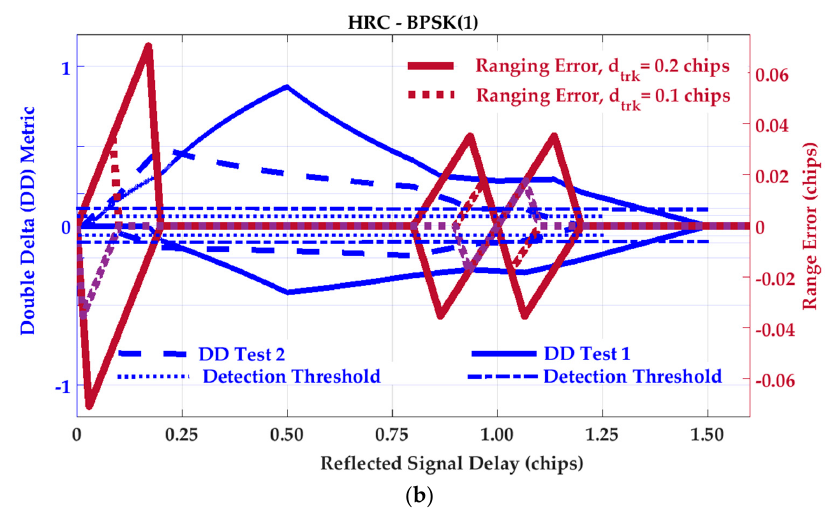
Figure 6. SQM profiles for Double-Delta metric and corresponding multipath error envelopes for ( a ) Narrow Correlator (NC) tracking strategy and BPSK(1) signaling scheme, SMR = 3 (dB); ( b ) HRC tracking strategy and BPSK(1) signaling scheme, SMR = 3 (dB).